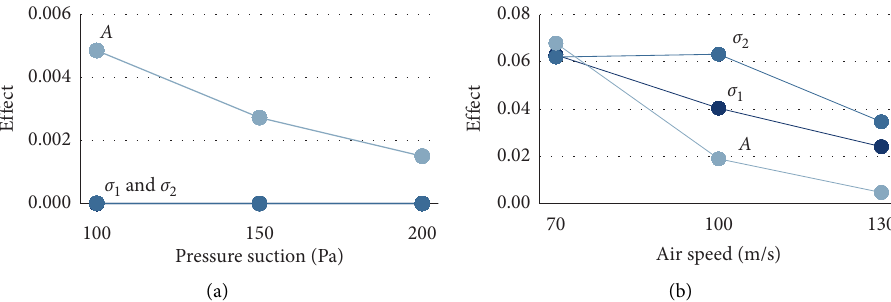
/ σ and less than 1 2